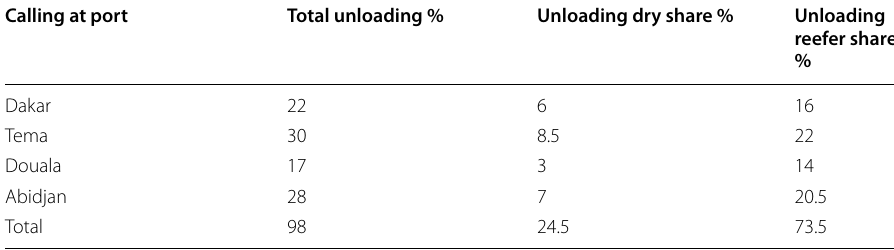
Table 11 Unloading cargo % of the vessel at African ports—scenario 2 Calling at port Total unloading %